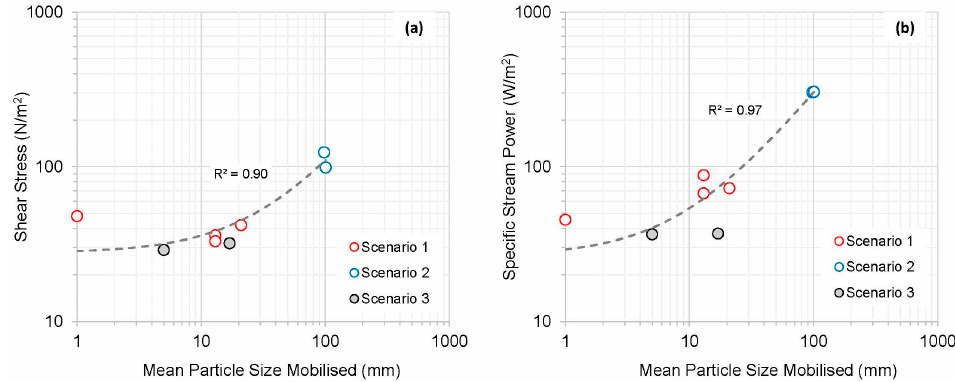
Figure 11. Relation linking ( a ) critical shear stress and ( b ) specific stream power to the mean particle size mobilised. Note that the critical shear stress and the specific stream power values are attributed to the peak flows of each hydrological scenario (see Section 4.2 for details). Note that a lineal model is fitted to all data together with the R 2 of the relationship. Even so, these models aim at indicating the general trend but in any case the objective is to predict bed mobility.